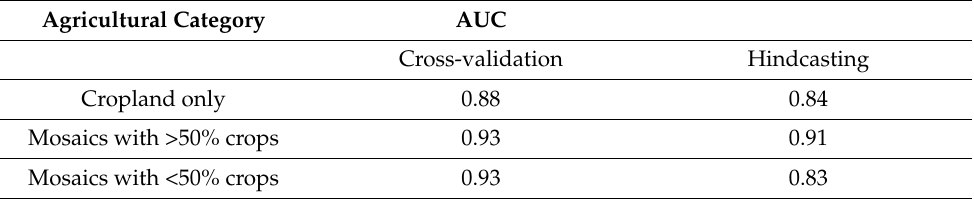
Table 2. Model performance as measured by the area under the curve of the receiver operator characteristic (AUC), shown for three categories of agricultural land and two evaluation procedures. For the cross-validation, we used two-thirds of the 2007–2020 data to train the models and the remaining third for evaluation. Hindcasted models were trained on the entire dataset containing the conversions from 2007 to 2020 and evaluated on a dataset from the preceding period